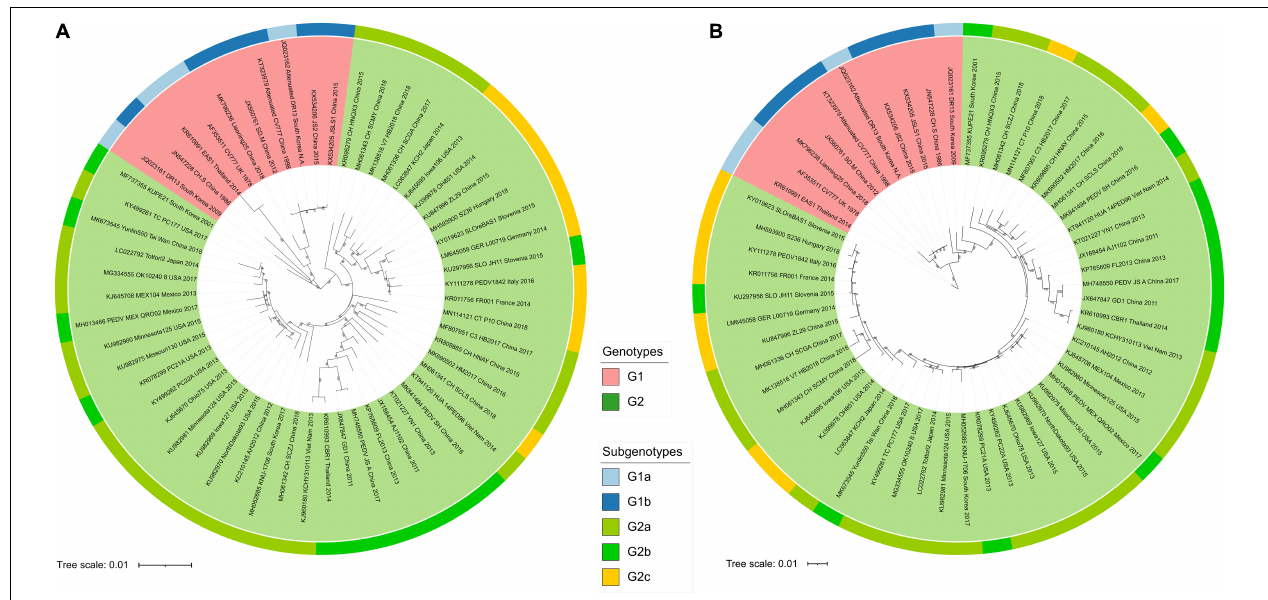
FIGURE 1 | The phylogenetic trees representing the relationship of the 56 PEDV strains based on the concatenated nucleic acid alignments of 56 CDS sequences. The phylogenetic trees were generated by using the neighbor-joining (A) and maximum-likelihood (B) method, respectively. The reliability of the neighbor-joining tree was evaluated by the bootstrap methods with 1,000 replicates in MEGA-X software (version 10.1.8), whereas the maximum-likelihood phylogenetic tree was analyzed by IQ-TREE using the ultrafast bootstrap option with 1,000 replicates. Bootstrap support values were labeled only if equal or larger than 50%. The tree is drawn to scale, with branch lengths measured in the number of substitutions per site. GenBank accession numbers of strains, years, places of isolation, genogroups, and subgroups are